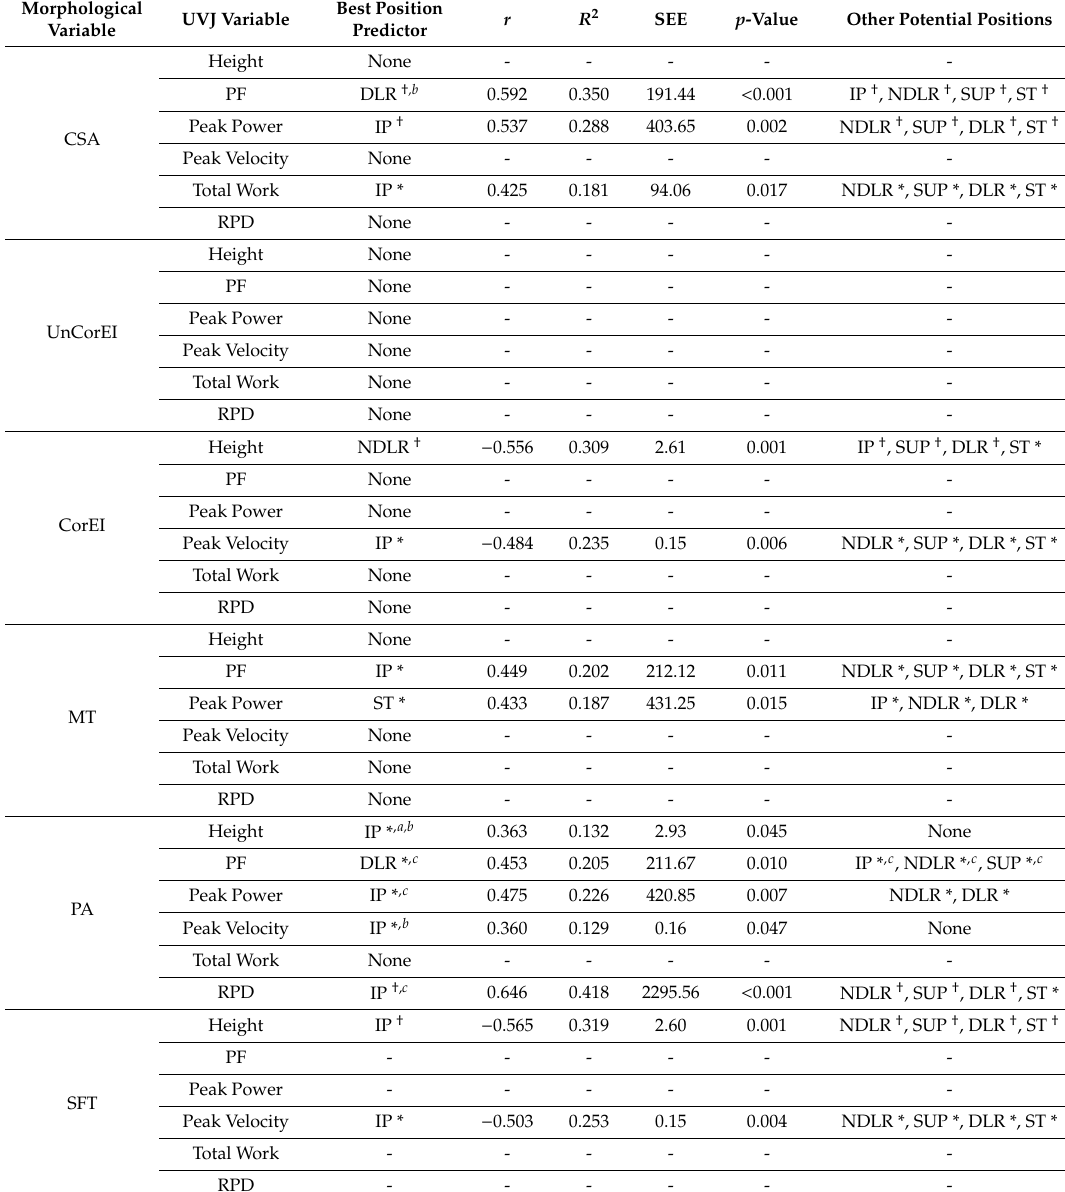
Table 5. Associations between ultrasound-derived muscle morphological characteristics after rest in di ff erent positions and unilateral vertical jump (UVJ) outcome